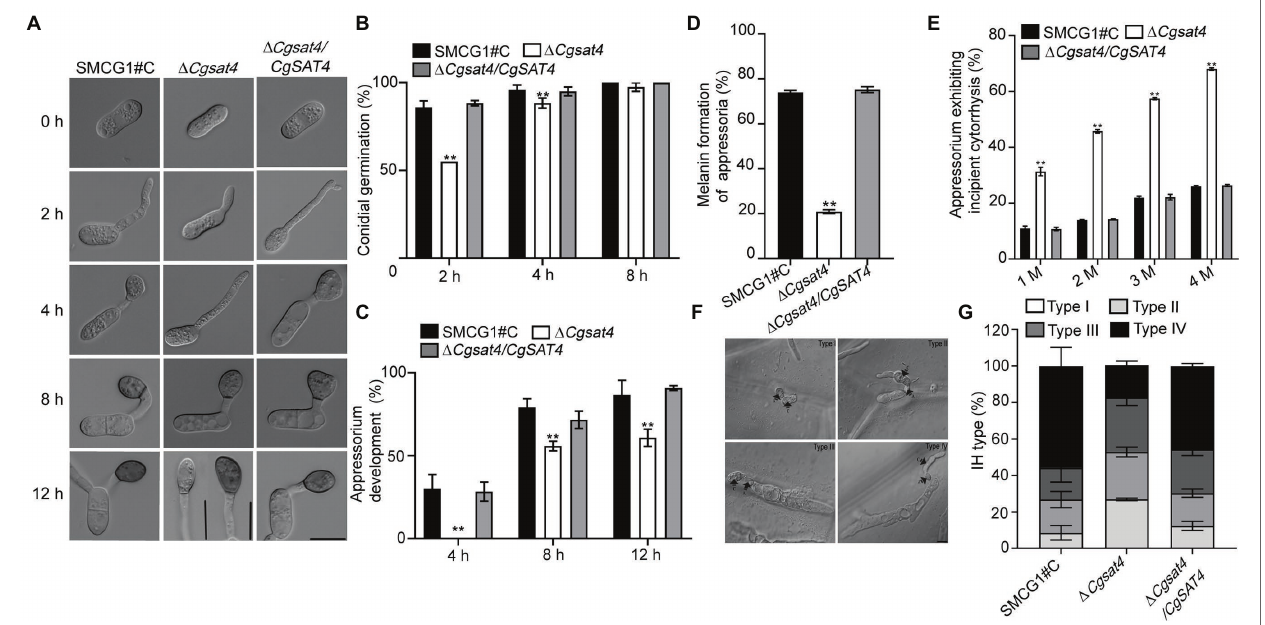
FIGURE 4 | CgSat4 is required for functional appressorium and invasive hyphal development. (A) Conidia and appressoria generated by the WT, ∆ Cgsat4 mutant and the complemented strain on hydrophobic slides at 0, 2, 4, 8, and 12 h and photographed. n = 100. Bar = 10 μ m. (B) Conidial germination rate of the WT, ∆ Cgsat4 mutant and the complemented strain at 2, 4, and 8 h, respectively. n = 100. (C) Appressorium formation rate of the WT, ∆ Cgsat4 mutant and the complemented strain at 4, 8, and 12 h, respectively. Error bars represent the SD. Asterisks indicates significant difference at p < 0.01. n = 100. (D) Melanized appressoria rate of the WT, ∆ Cgsat4 mutant, and complemented strain. n = 100. (E) Collapsed appressoria rate of the WT, ∆ Cgsat4 mutant, and complemented strain. n = 100. Error bars represent the SD. Asterisks indicates significant difference at p < 0.01. (F) Morphology of different types of invasive hypha developed on onion epidermal cells for 24 h. n = 100. (G) Proportion of different type of invasive hypha (type I, no hyphae penetration; type II, IH with one branch; type III, IH with at least two branches, but having limited expansion; type IV, IH with numerous branching and extensive hyphal growth) in the WT, ∆ Cgsat4 mutant and complemented strain. Error bars represent the SD. n = 100. Bar = 10 μ